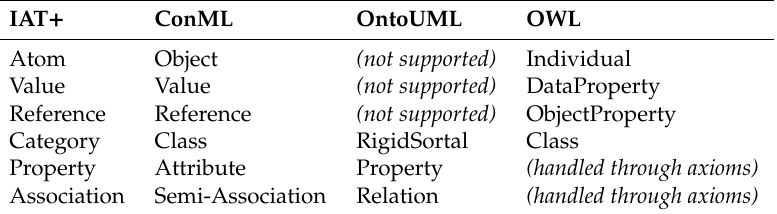
Table 1. Mappings between IAT + ontology element subtypes and modelling primitives of common conceptual modelling